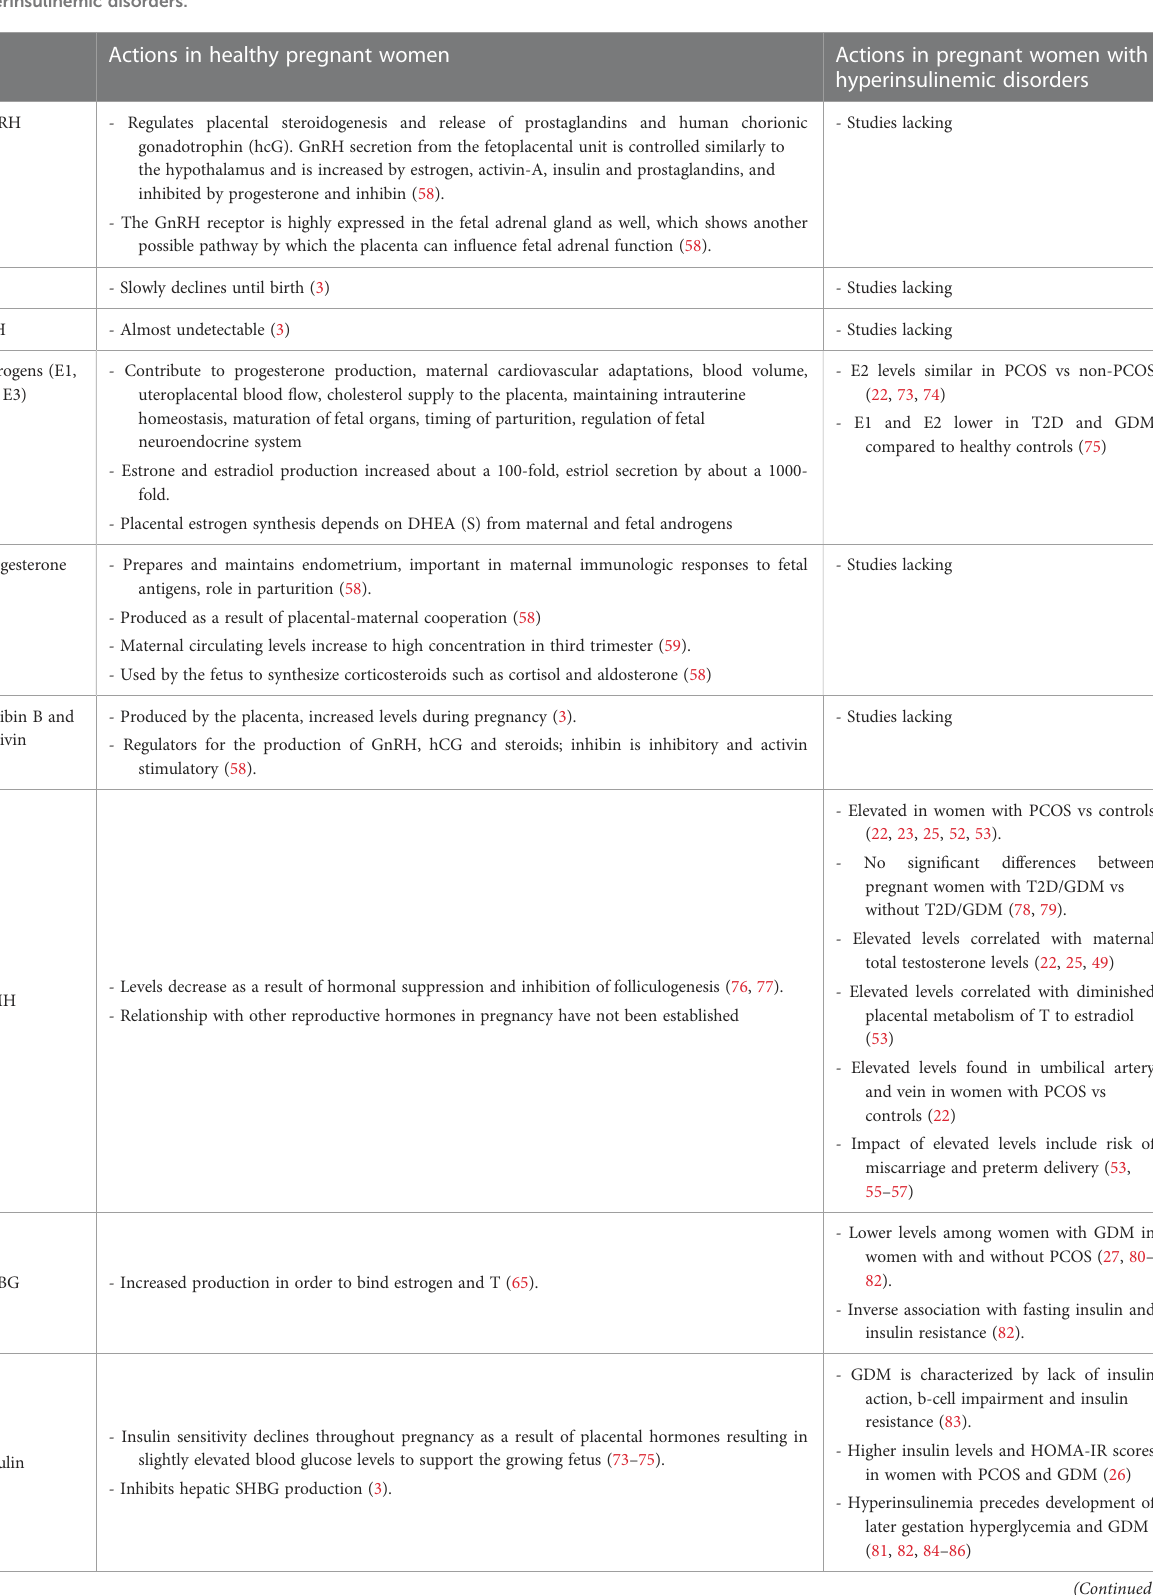
TABLE 1 Physiology of the feto-placental unit and the in fl uence of metabolic factors in healthy pregnant women vs pregnant women with hyperinsulinemic